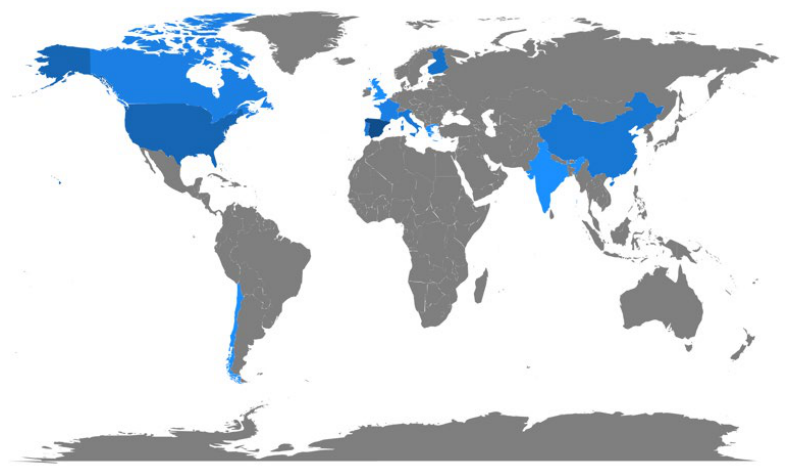
Figure 5. World’s scientific production using R-studio software (Version 1.4.1106) and bibliometrix library of the automated waste collection system (AWCS) scientific literature found in Scopus.